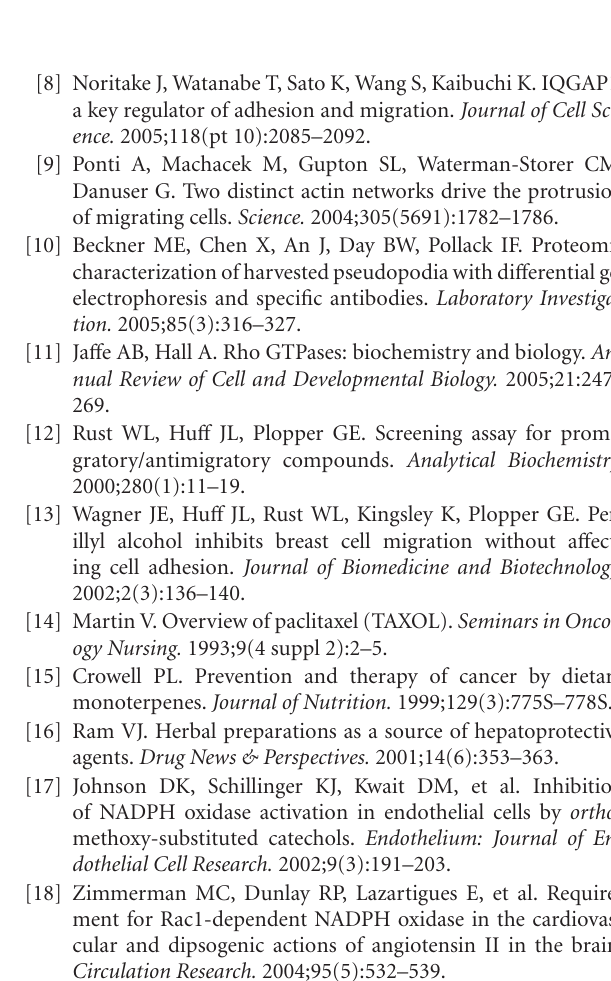
Figure 6: (a) Western blot of MDA-MB 435 breast cancer cells cultured on fibronectin for 1hour. Active Cdc42 was isolated using a PAK- PBD pull down assay. Positive control (lane 1) and ethanol control (lane 2) were compared to cells treated with 36ng/ μ L of either compound A5, A8, 5, or 9 (lanes 3, 4, 5, and 6, resp) by probing with a monoclonal antibody for Cdc42. (b) Densitometric analysis of Cdc42 band